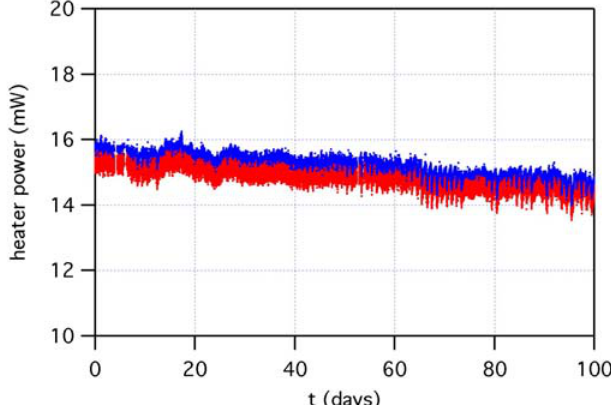
Figure 8. Heating power of both gas sensors, along the period between December 2010 and March 2011. The continuous -although slow- drift toward lower power unveils that some change in heater is taking